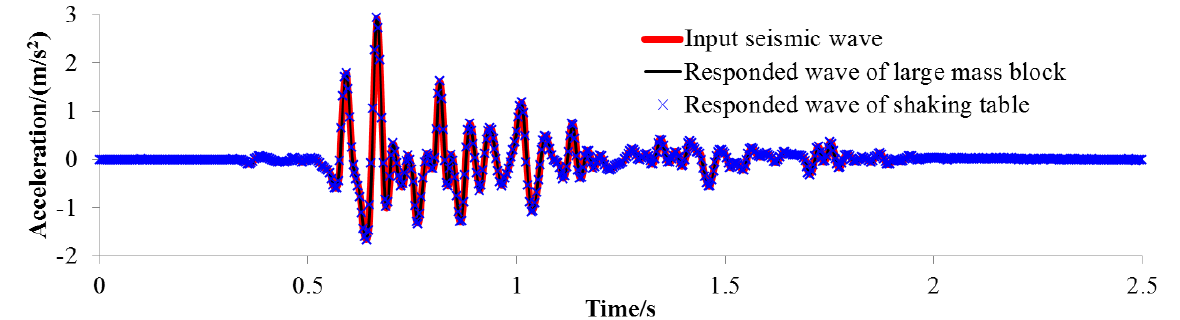
Figure 11. Input seismic wave and verification of large mass method.